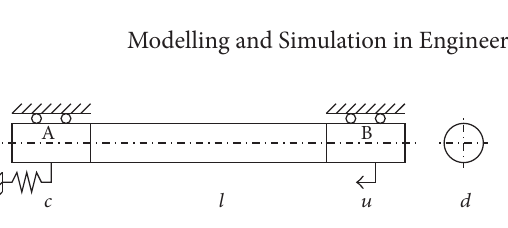
Figure 1: Schematic of the buckling FE model. The bar is a circular cylinder of gauge length 𝑙 and of diameter 𝑑 . Side surface nodes in region A are attached to a spring of stiffness 𝑐 . Prescribed axial displacement 𝑢 is applied to all side surface nodes in region